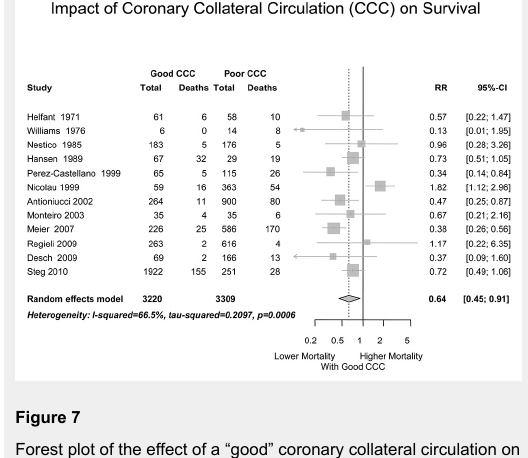
Forest plot of the effect of a “good” coronary collateral circulation on all-cause mortality of patients with coronary artery disease. In all studies except for one, “good” collaterals were defined angiographically as extensive filling of the main coronary branch of interest via anastomoses from an adjacent